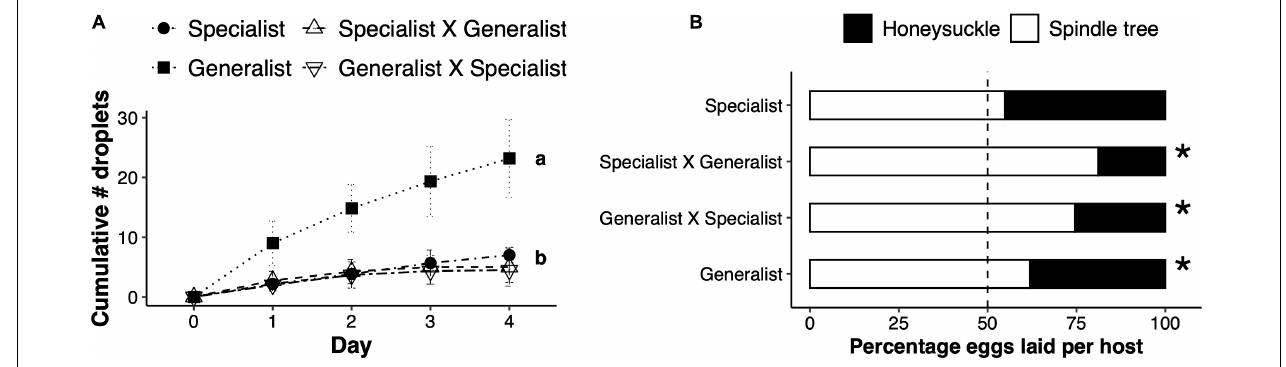
FIGURE 5 | Inheritance of adaptive traits in F1 hybrid females. (A) Total number of sticky droplets (mean ± SEM) produced on honeysuckle leaves per day of herbivory by either honeysuckle specialist Tetranychus urticae females, generalist females, or their reciprocal F1 hybrids (female × male in the legend). Letters represent a significantly different number of droplets produced between treatments. (B) Percentage of the total number of eggs laid on honeysuckle or spindle tree (legend) by either specialist, generalist or F1 hybrid females. Stars next to a bar represent a significant difference from a 0.5:0.5